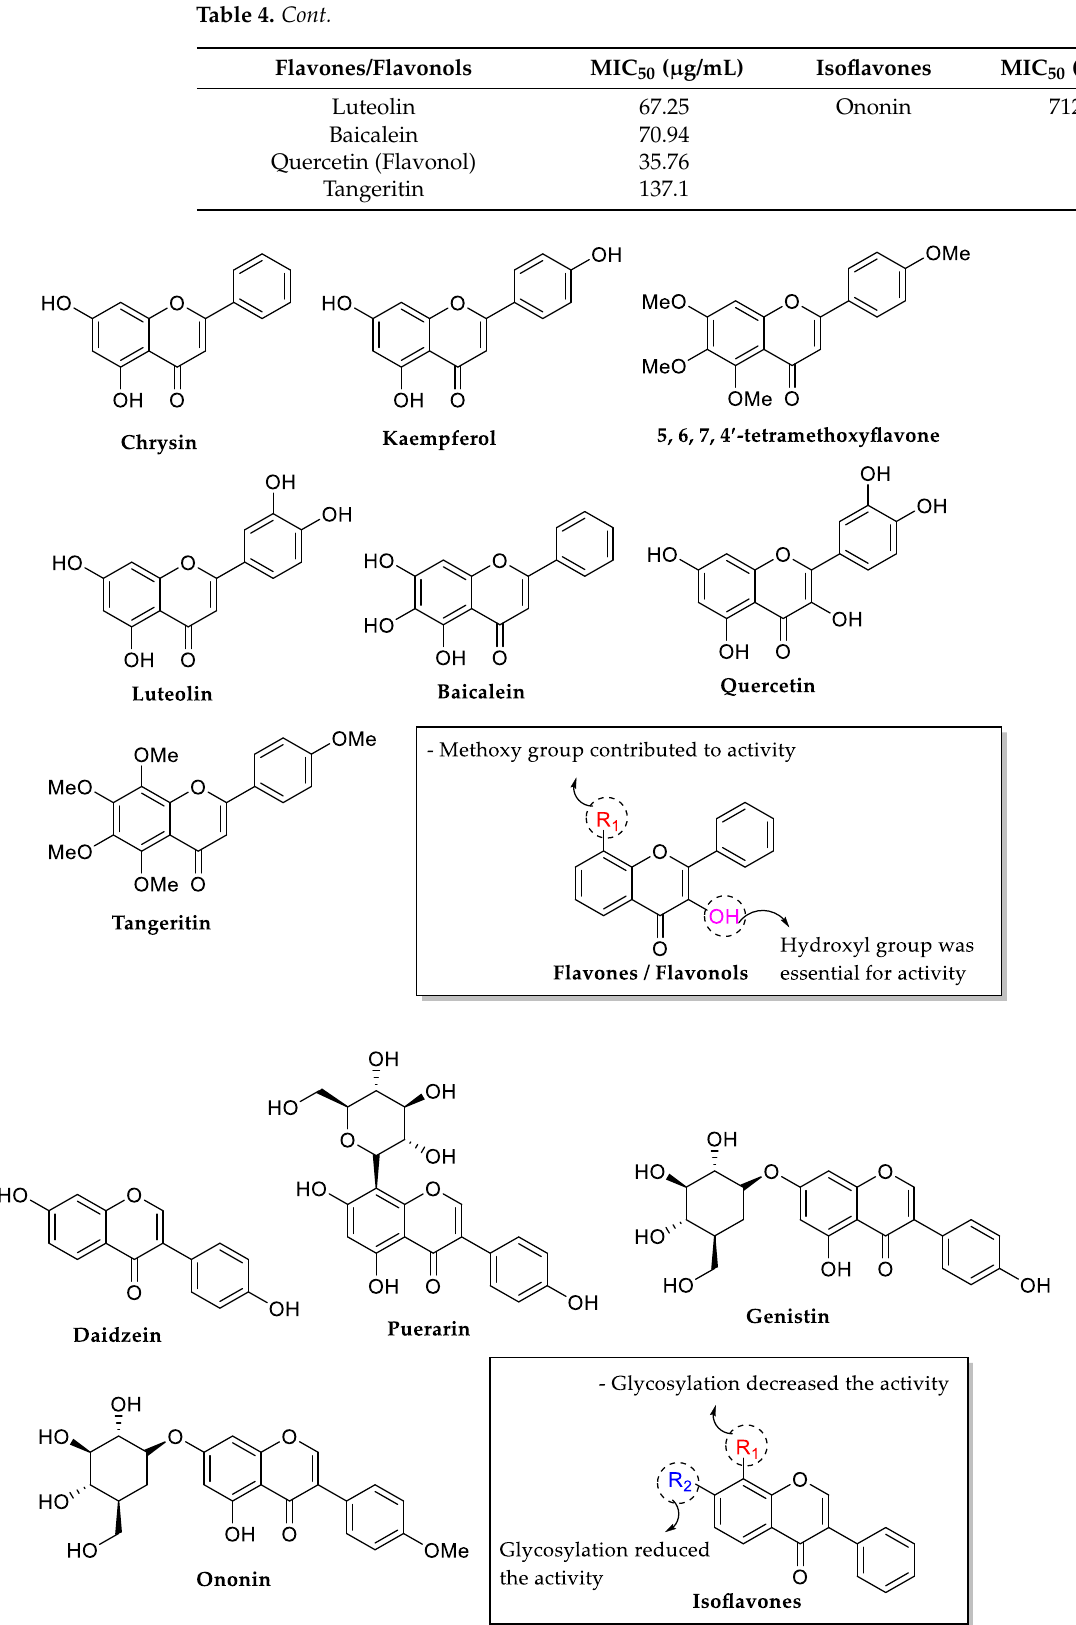
Figure 6. The SAR of flavonoids as antibacterial by inhibiting the growth of E. coli [73].